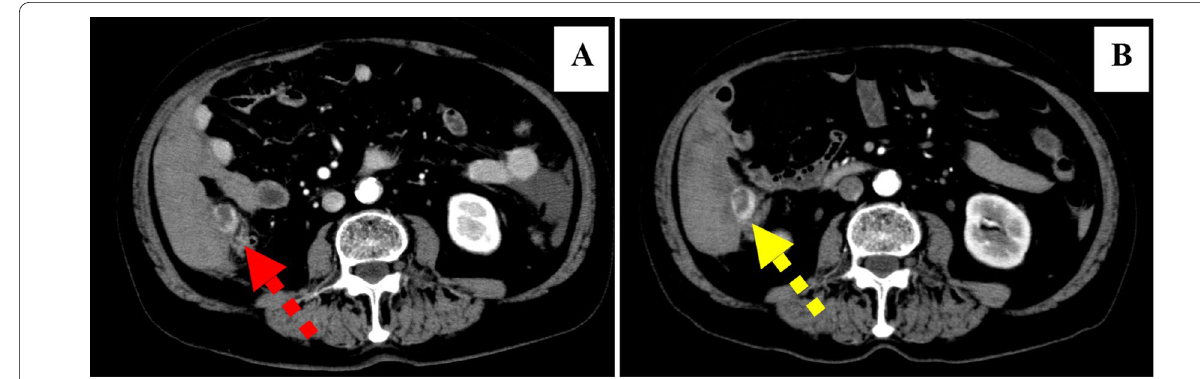
Fig. 1 Preoperative contrast-enhanced CT. A CT image of the patient when he first came to the hospital with abdominal pain. B Preoperative CT image when the abdominal pain recurred 1 week after ( A ). A ring-shaped contrast area (arrows) between the ascending colon and the retroperitoneal hematoma. The anemia had worsened, but the size of the hematoma had not changed